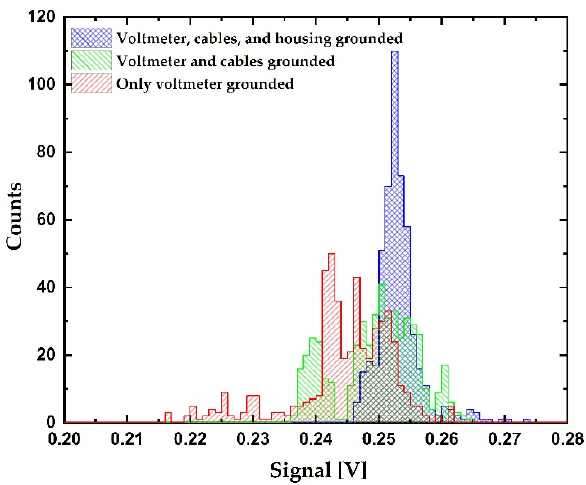
Figure 13. Histogram of the signal: red—voltmeter is grounded; green—voltmeter and cable shields are grounded; blue—voltmeter, shields, and housing are grounded. Number of events is 501 in all cases. Bin size is 1 mV. Table 3. Standard deviation, mean, and signal-to-noise ratio of the three considered configurations.